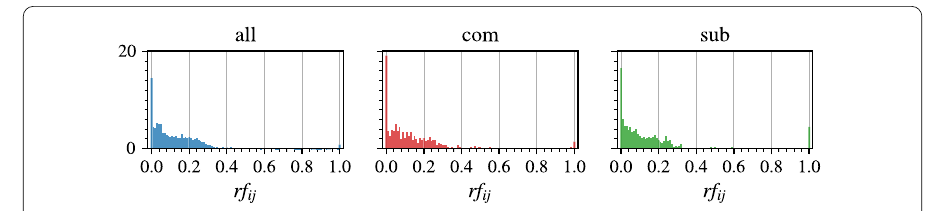
Figure 11 Distributions of the relative number of shared flavour compounds of all product pairs { rf ij } (“all”), of complementary pairs { rf ij : W ( c ) ij > 0 } (“com”) and of substitute pairs { rf ij : W ( s ) ij > 0 } (“sub”), where probabilities of rf ij = 0 and rf ij = 1 are of interest